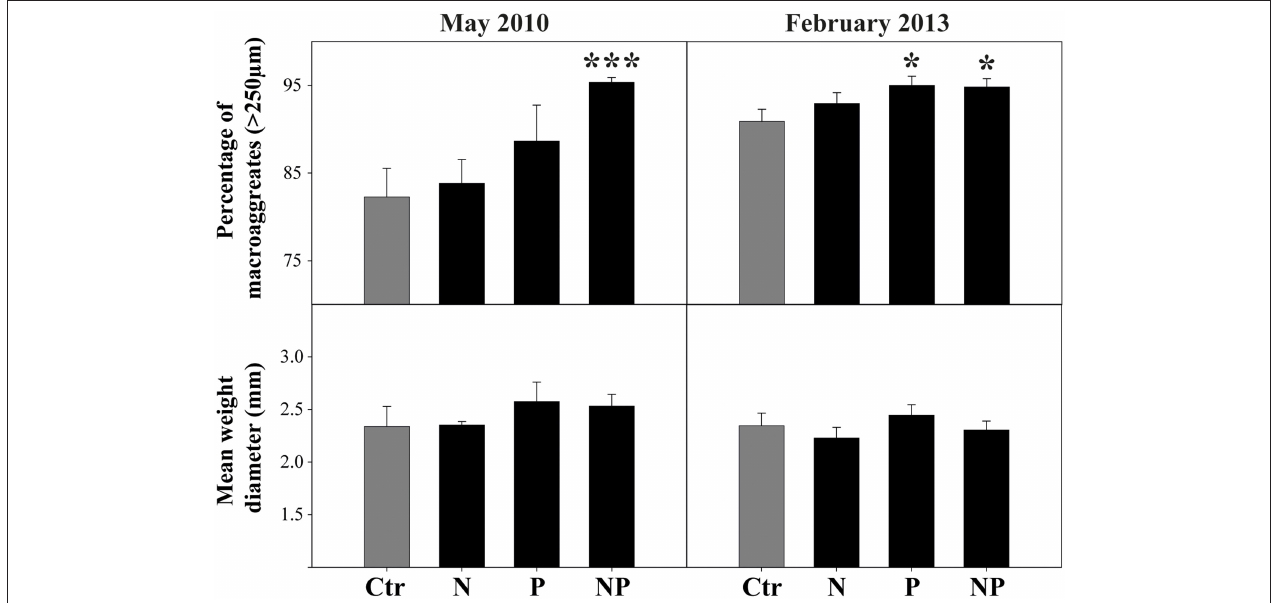
FIGURE 1 | Responses of the amount of water-stable macroaggregates as well as soil mean weight diameter to N and P additions in a tropical premontane forest soil. Bars represent mean values, error bars the respective standard error. Asterisks indicate significant differences compared to the control treatment (one-way linear mixed-effects model; P < 0.05